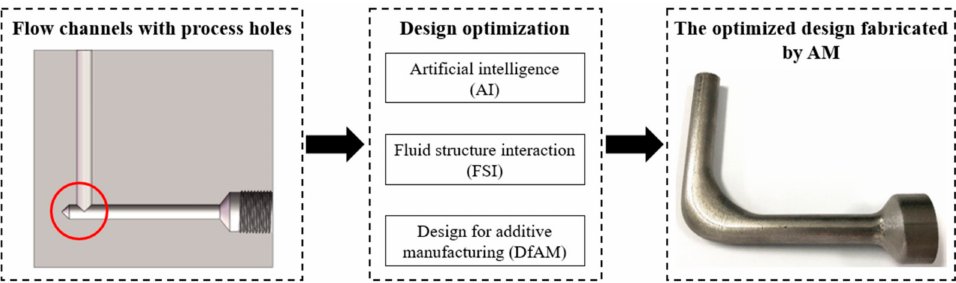
Figure 1. The traditional right-angle flow channel optimized by the intelligent design optimization system and fabricated by